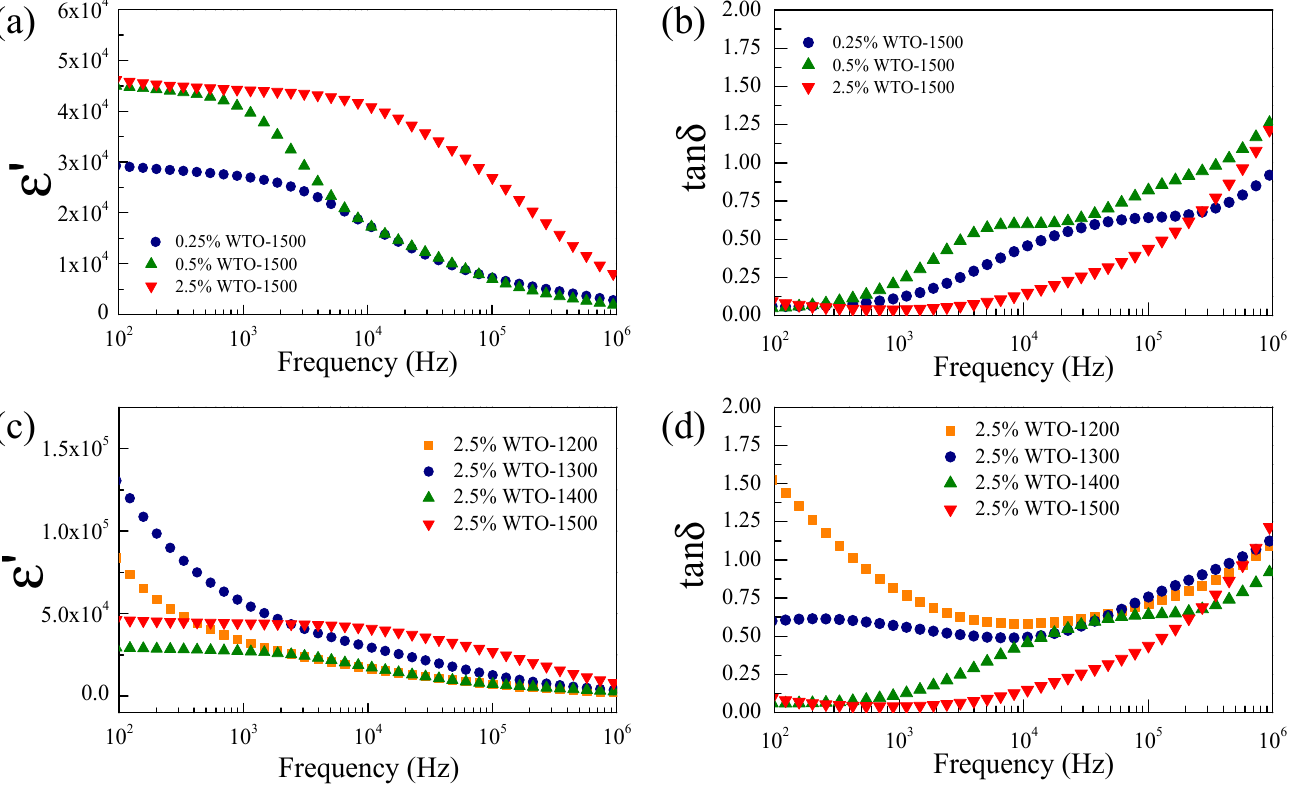
Figure 5. ( a , b ) Frequency dependence of ε ′ and tan δ at room temperature for WTO ceramics doping with W 6+ concentration (sintered at 1500 °C for 5 h). ( c , d ) Frequency dependence of ε ′ and tan δ at room temperature for 2.5%WTO sintered at different temperatures (1200–1500 °C).